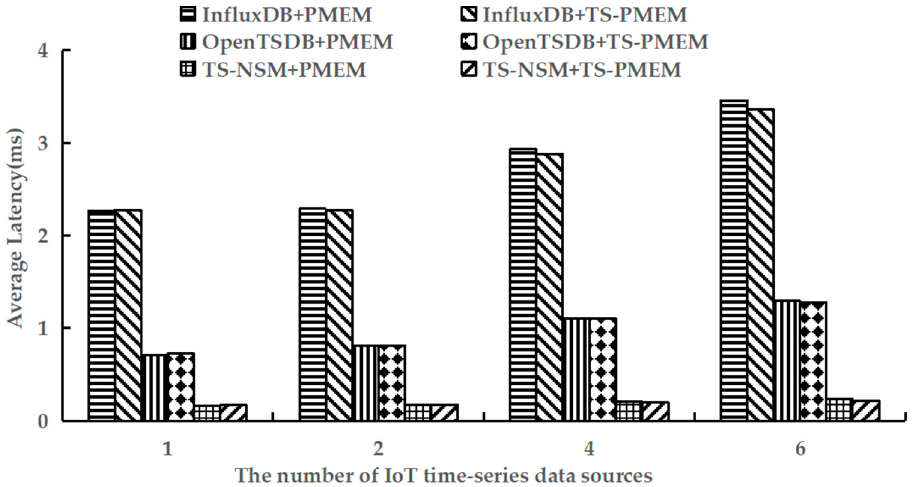
Figure 7. Average write latency under testworkloada.